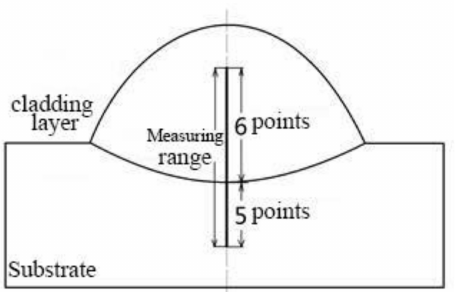
Figure 10. Schematic illustration of micro-hardness test points.